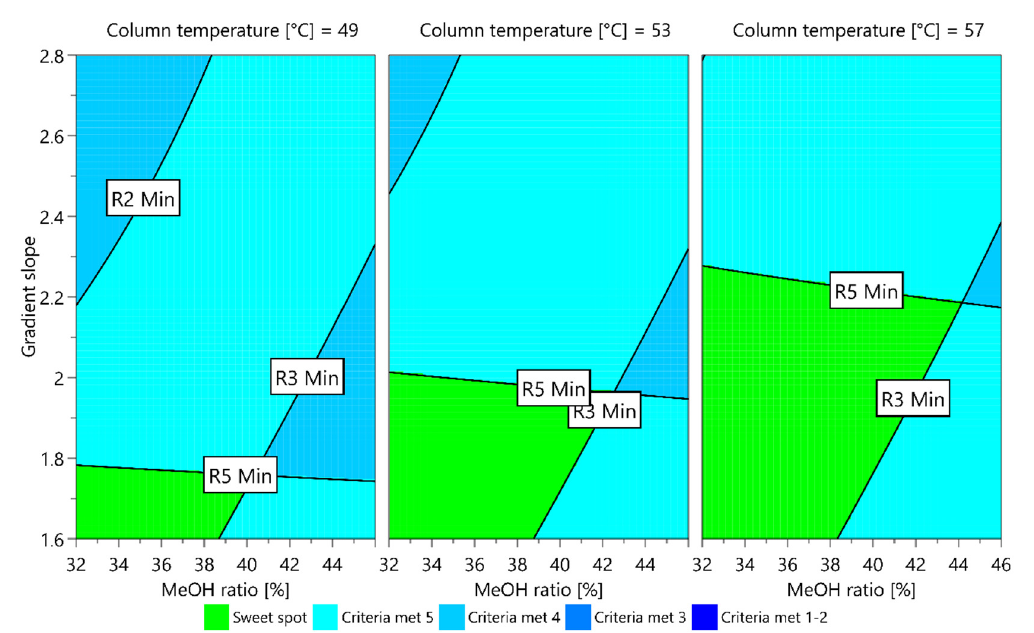
Figure 4. Sweet spot plot obtained for a central composite face-centered design MLR fitted model when unknown degradation impurity is eluting before impurity C. The green field is a sweet spot where all CMA criteria are met.